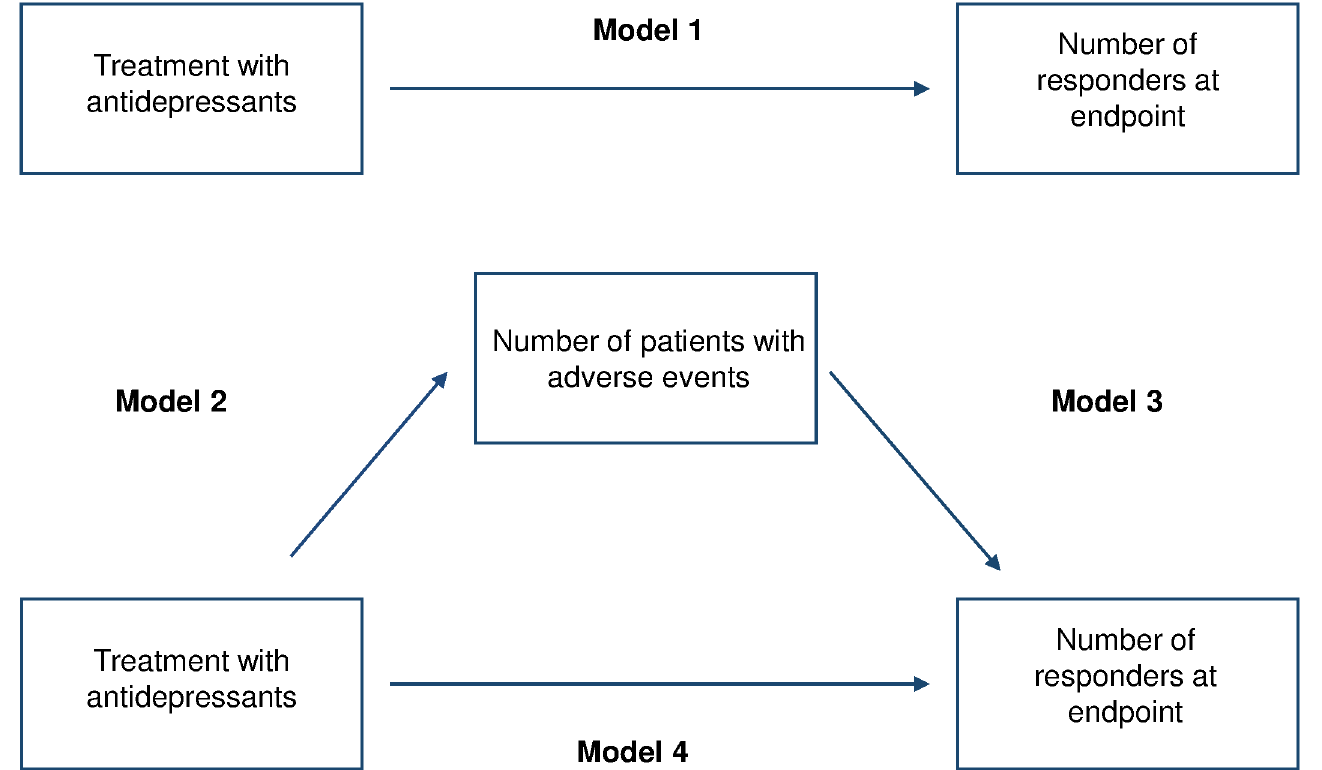
Fig 1. Baron and Kenny mediational model. The model shows both the direct and the mediatedpathwaysby which antidepressants treatment influencesefficacy. The mediatedpathway investigates the potential mediational role of adverseevents in the relationshipbetweenantidepressant treatment and the number of responders at